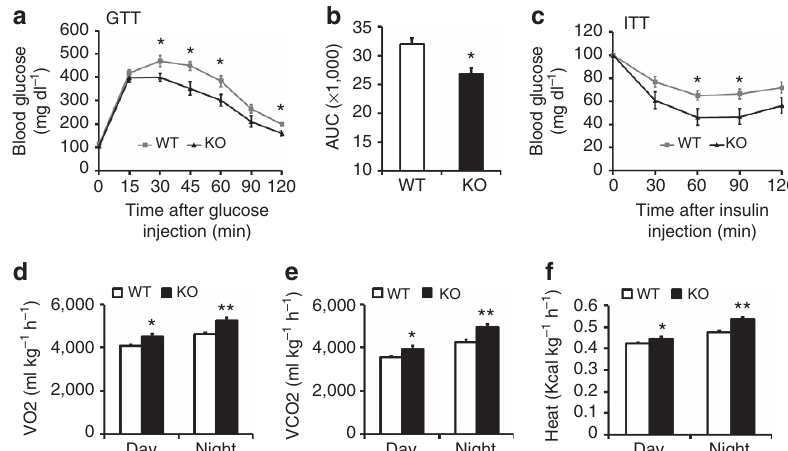
Figure 3 | Improved glucose tolerance and insulin sensitivity and higher metabolic rate in Adipoq-Lkb1 KO mice. ( a ) Blood glucose concentrations during glucose tolerance tests (GTT) performed on 6-week-old WTand KO male mice ( n ¼ 7). ( b ) Area under curve (AUC) calculated based on data in a . ( c ) Blood glucose concentrations during insulin tolerance tests (ITT) performed on 10-week-old WT and KO male mice ( n ¼ 8). ( d – e ) Average day and